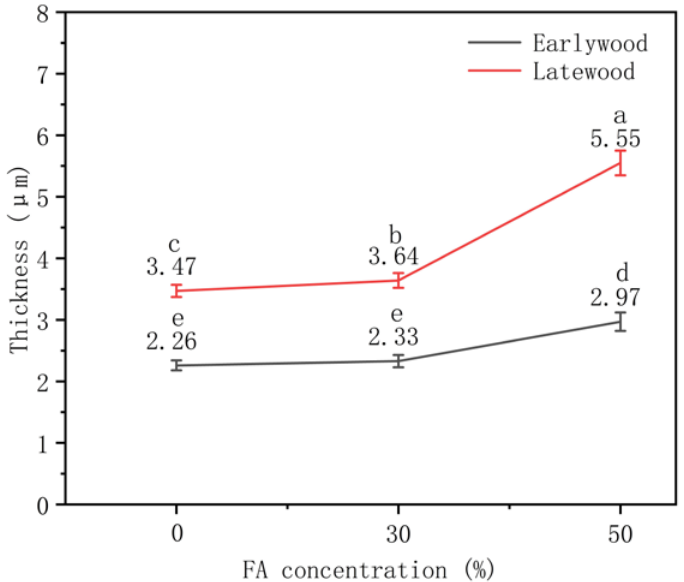
Figure 5. Cell wall thickness (numbers) and their significant differences (letters) of the control and furfurylated wood.